Question: Give a one-sentence summary of this figure.
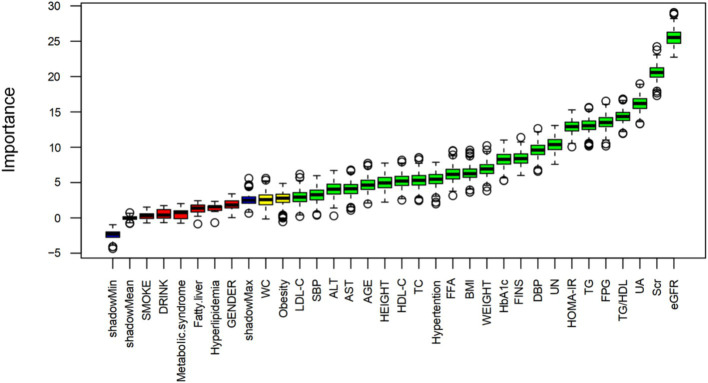
Answer: Feature selection with Boruta. The blue plot shows minimum, average, and max shadow score. Variables having box plot in green are important, in yellow as tentative, and in red as rejected.